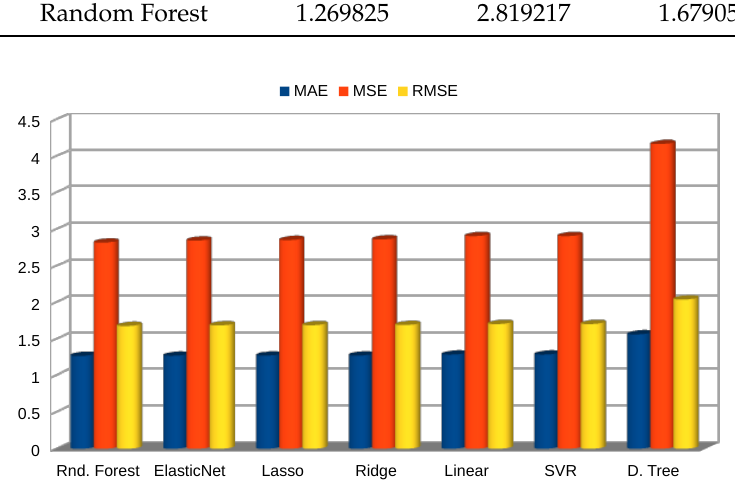
Figure 2. Model errors [ms − 1 ].